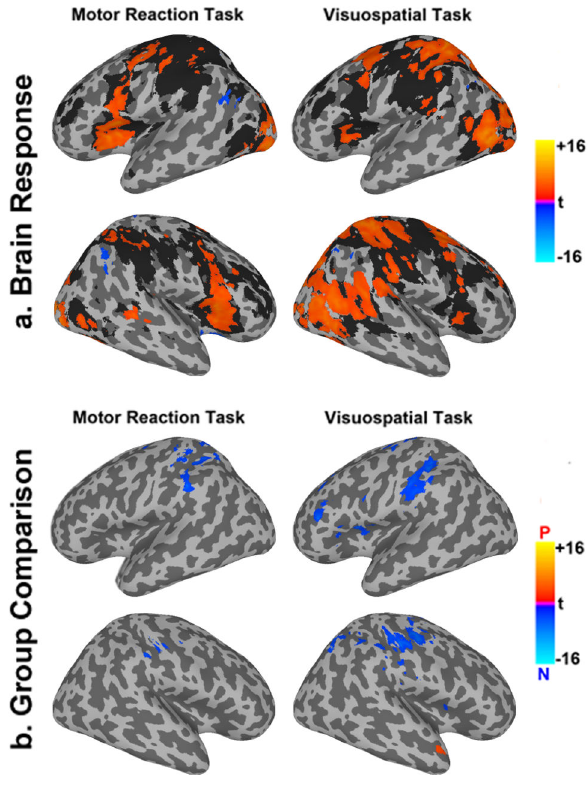
Figure 3. Brain activation results. (a) Brain activations in left (top) and right (bottom) hemispheres of professional (blue/ yellow scale) and naive (gray shadow) drivers during motor reaction (1st column) and visuo-spatial (2nd column) tasks computed at whole brain corrected p < 0.05. (b) Left (top) and right (bottom) hemispheres activation contrast maps for the two tasks, where blue color corresponds to regions significantly more activated in naive as compared to professional drivers, while red color corresponds to regions significantly more activated in the professional drivers group ( p < 0.05, whole brain